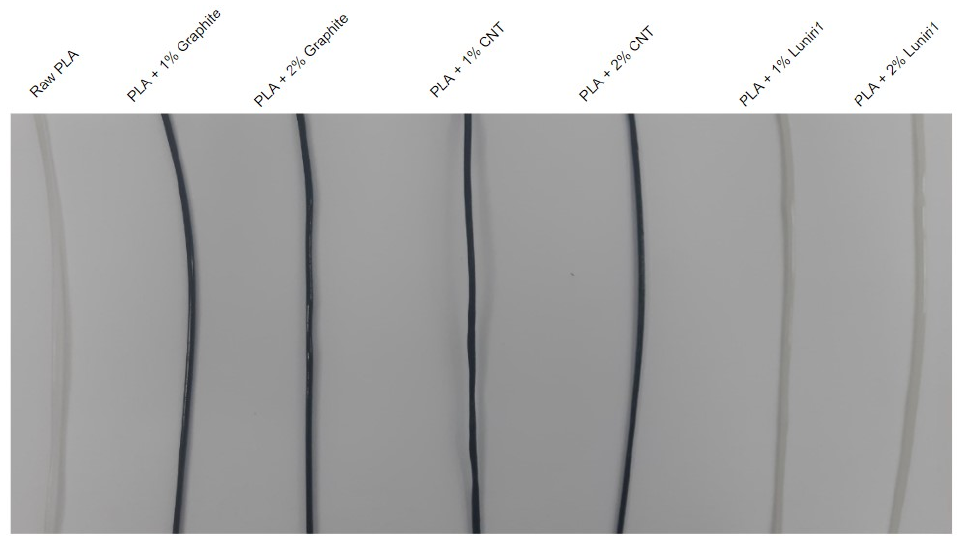
Figure 3. Filament development of PLA with additives.